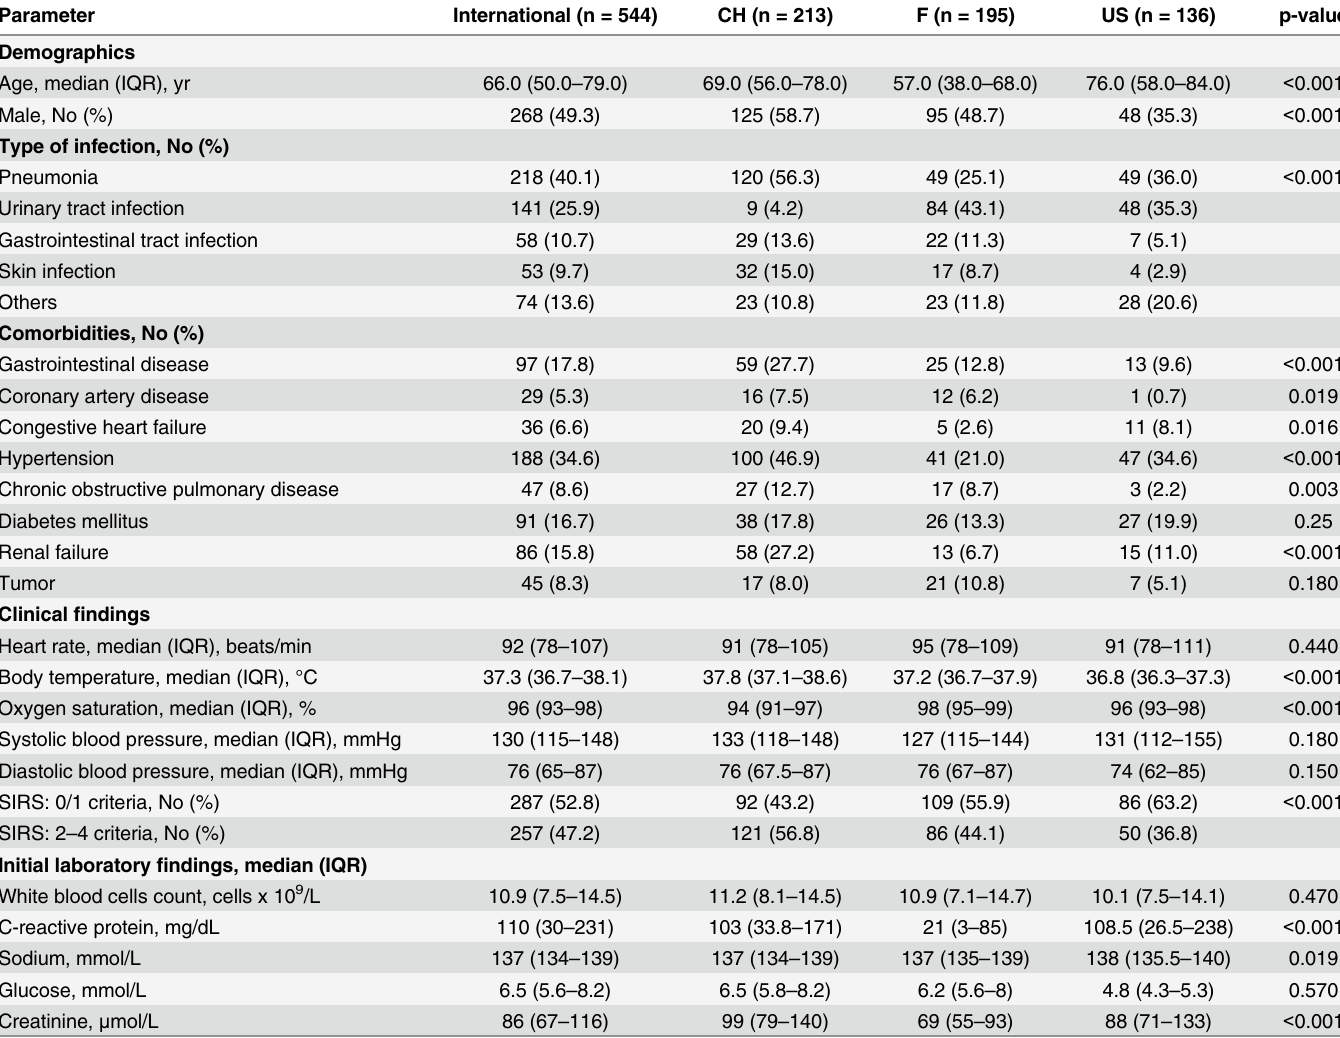
Table 1. Baseline